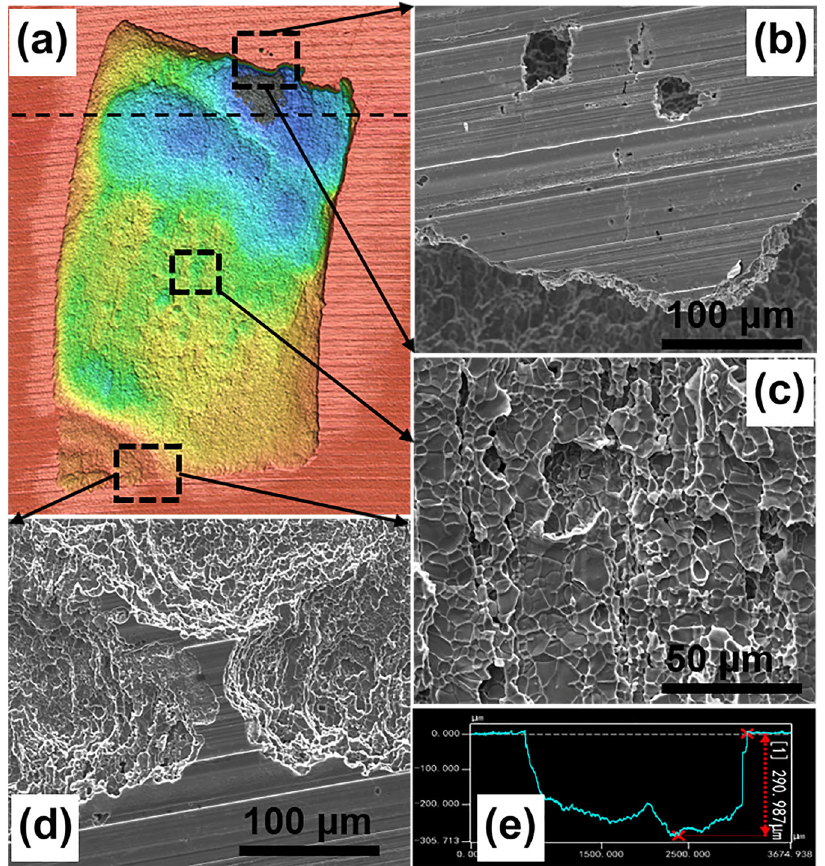
Fig. 6 Arti fi cial crevice corrosion morphologies of 2205 DSS after immersing for 36 months. a 3D pro fi le of the whole crevice area, b – d local magni fi cation of different corrosion zones, e topographic pro fi le of